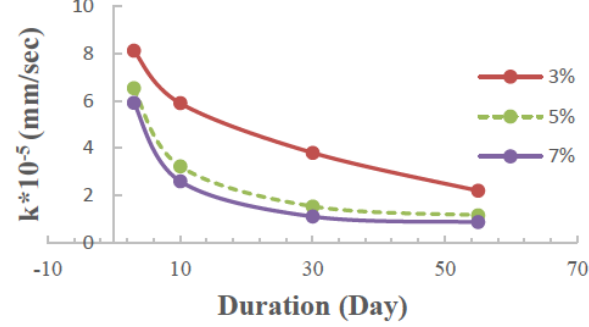
Figure 8: Relationship between falling water in a pipe for the con- stant head permeability test and the duration of time for untreated and 3%, 5%, and 7% stabiliser-treated soil after 3 days of soaking